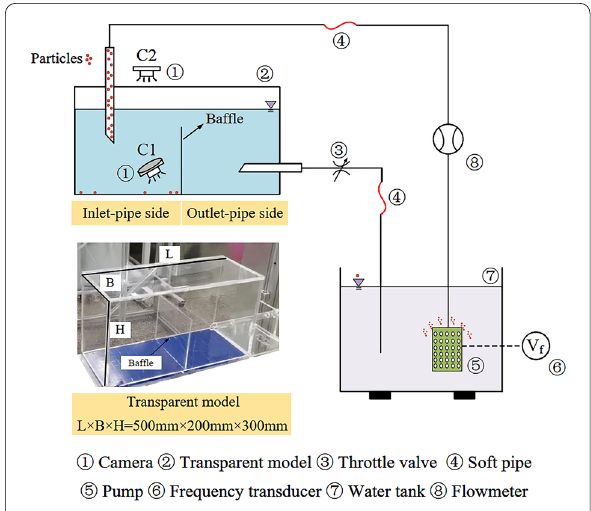
Figure 1 Diagram of particle deposition experiment